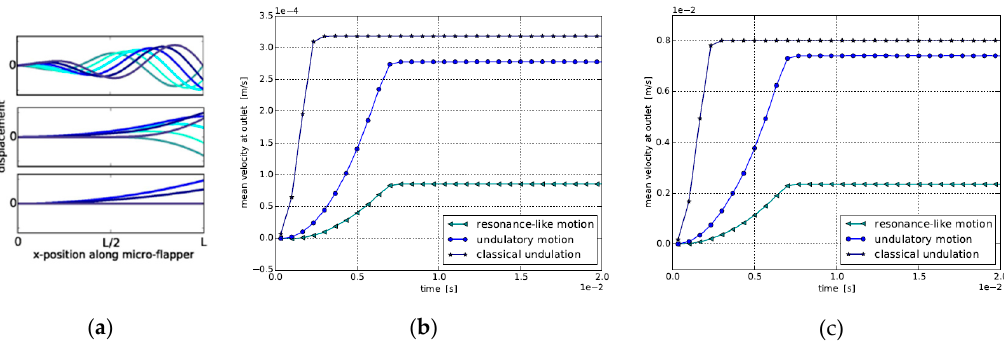
Figure 4. ( a ) Simulated motions of the flapper: Undulation with wavelike motion and increasing amplitude; undulatory motion reduced to the basic translatory und rotatory portion; resonant-like oscillation. ( b , c ) Time dependent volume flow at the outlet of the 2D micro channel for different amplitudes of deflection (( b ) 5 µm and ( c ) 25 µm).